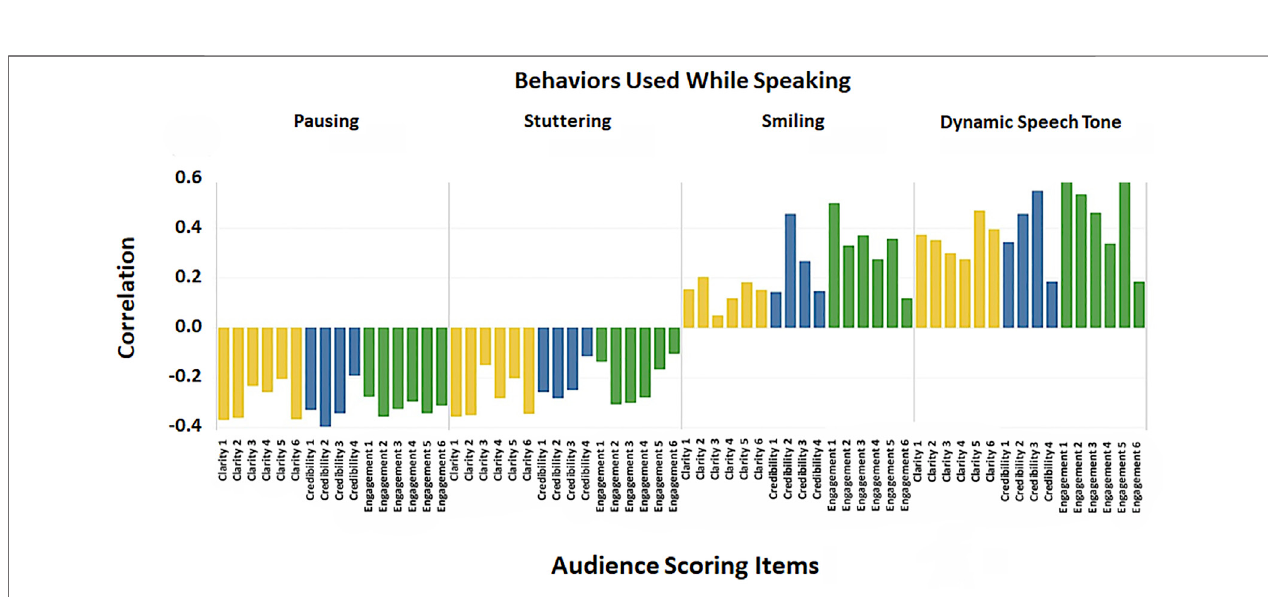
FIGURE6| Therelationshipofbehaviors exhibitedduring speakingtoclarity(yellow, leftbarineachpanel),credibility(blue,middle barineachpanel) andaudience engagement(green,rightbar ineach panel).Pausingandstutteringduringspeakingareassociatedwithlowscoresfromaudiencesonalldimensions ofcommunication performance; smiling and a dynamic speaking tone are associated with high scores from audiences. See Table 3 for correlation values.